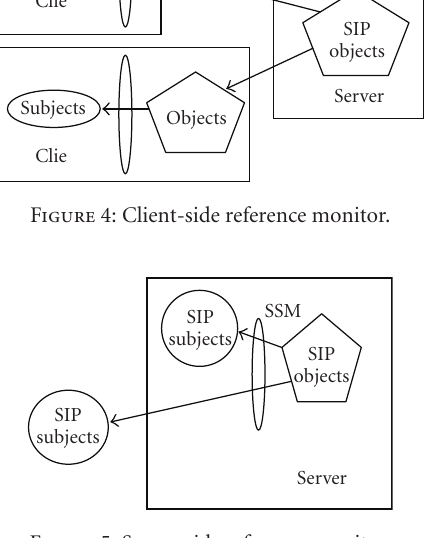
Figure 5: Server-side reference